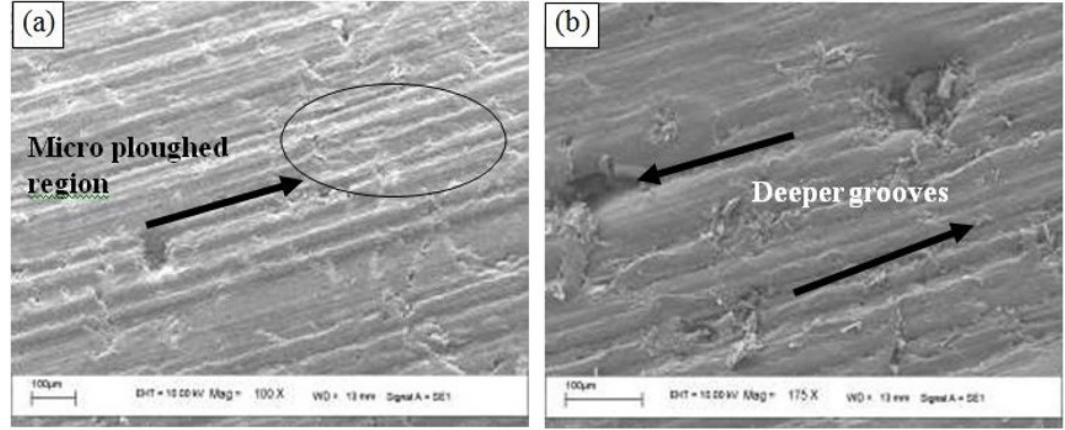
Figure 13. (a-b) SEM image of unreinforced epoxy material at 29.43